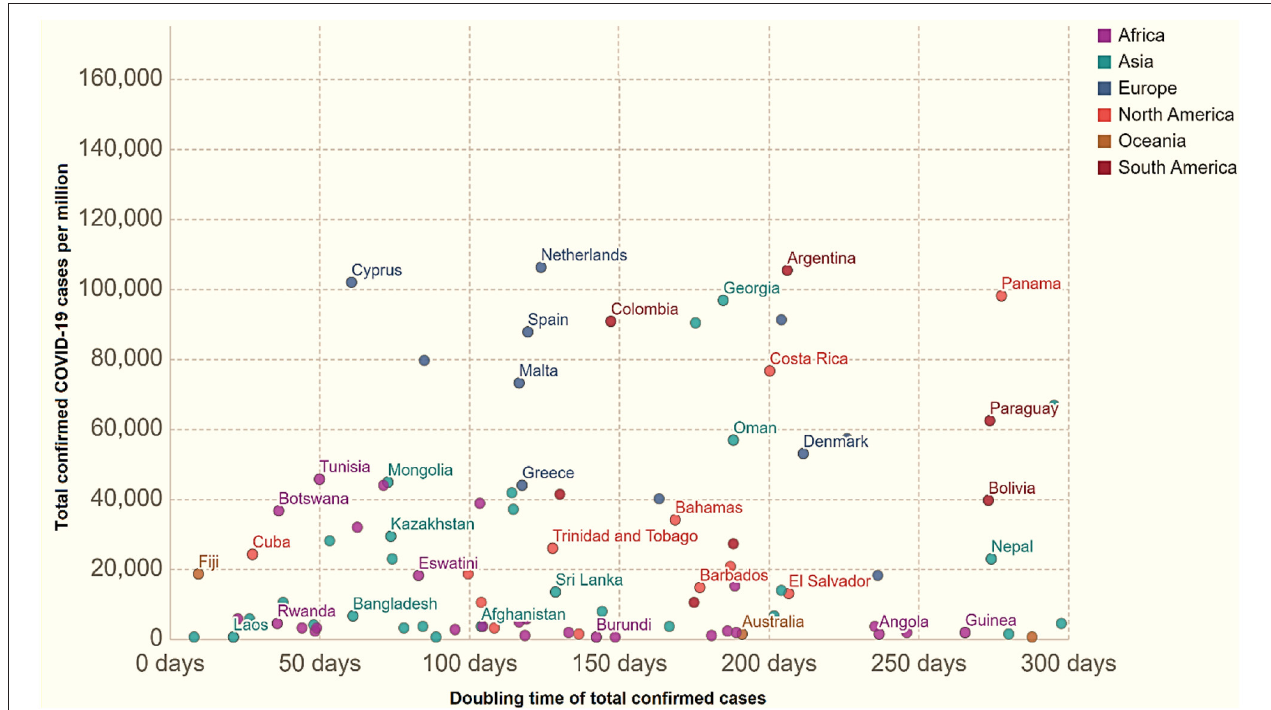
FIGURE 4 | Total recorded COVID-19 cases/million vs. how quickly these figures double as of July 18, 2021.